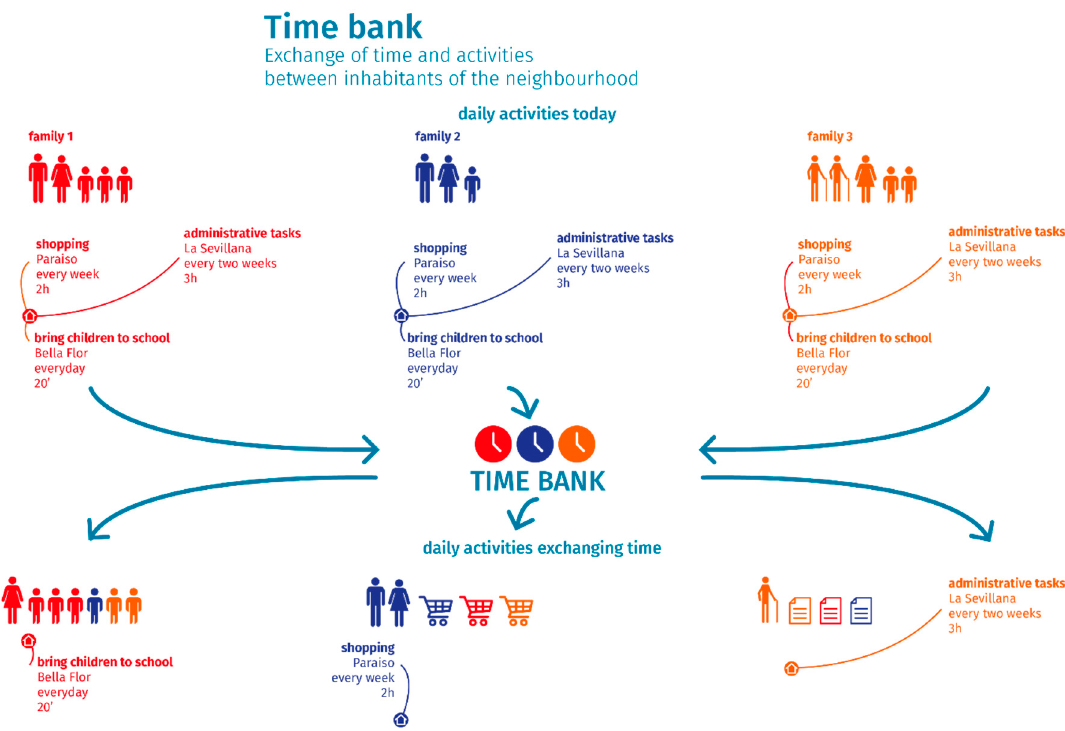
Figure 6. A suitable matchmaking example: Functioning of a local time bank for the La Torre neighbourhood (source: [50]).